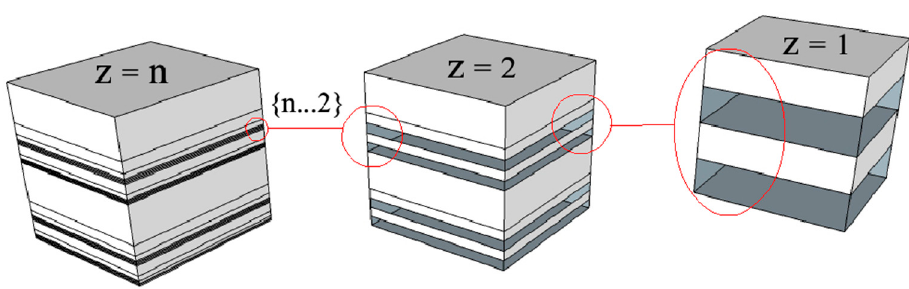
Figure 1. Model of a layered hierarchically constructed composite.